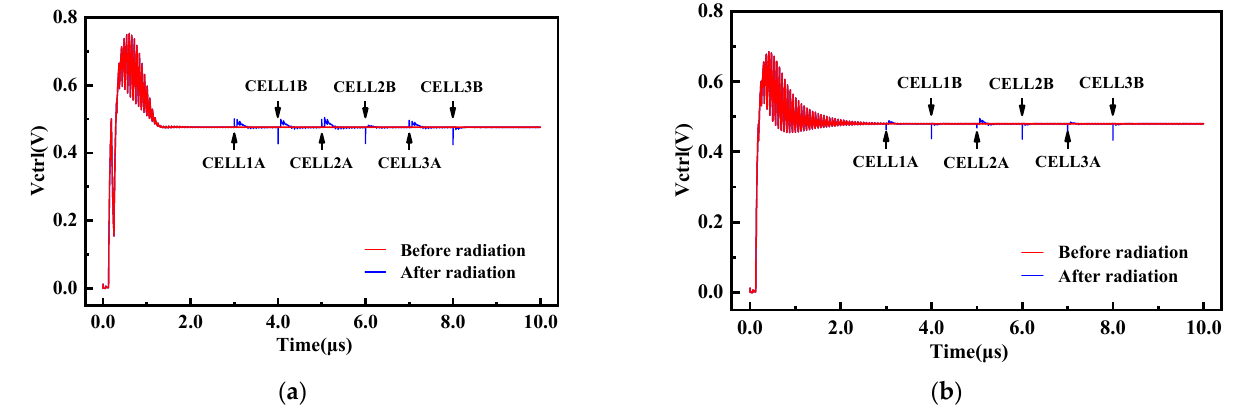
Figure 12. Simulation results of the PLL control voltage disturbance. ( a ) Unhardened VCO. ( b ) Hardened VCO. Figure 11. Simulation results of node voltage disturbance of the VCO delay cell. ( a ) Strike at node A. ( b ) Strike at node B .